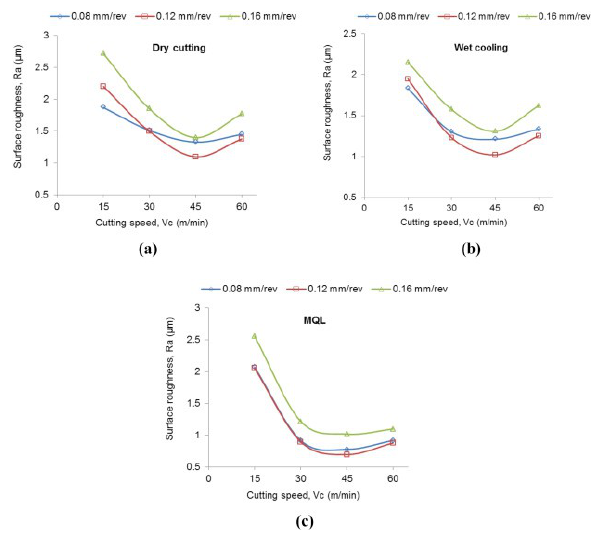
Figure 11: Surface roughness results for a) dry cutting b) wet cutting c) MQL